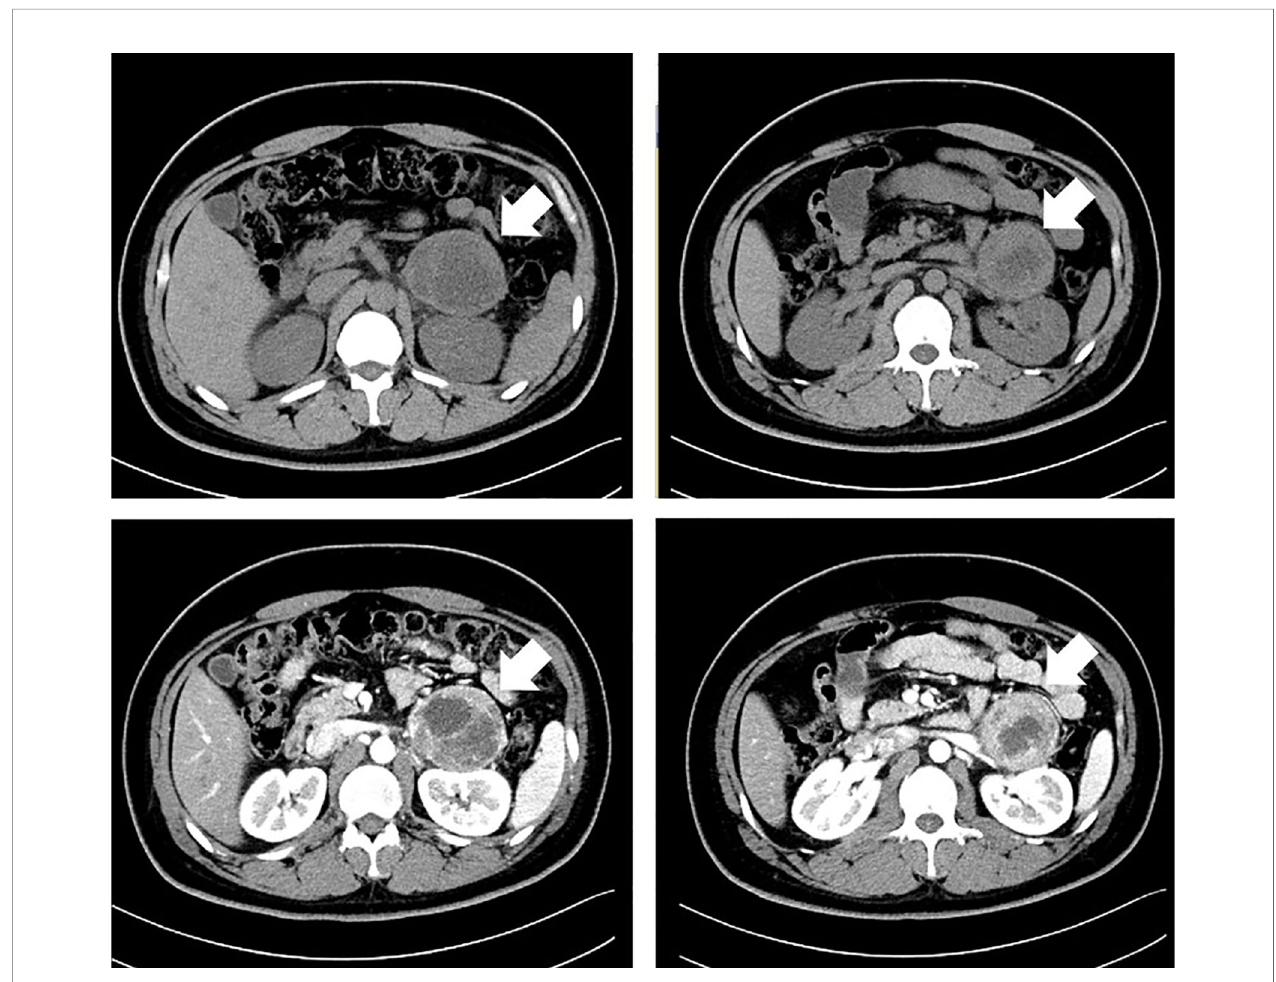
FIGURE 2 | A computed tomographic (CT) scan of the abdomen with intravenous contrast in the patient with a left adrenal